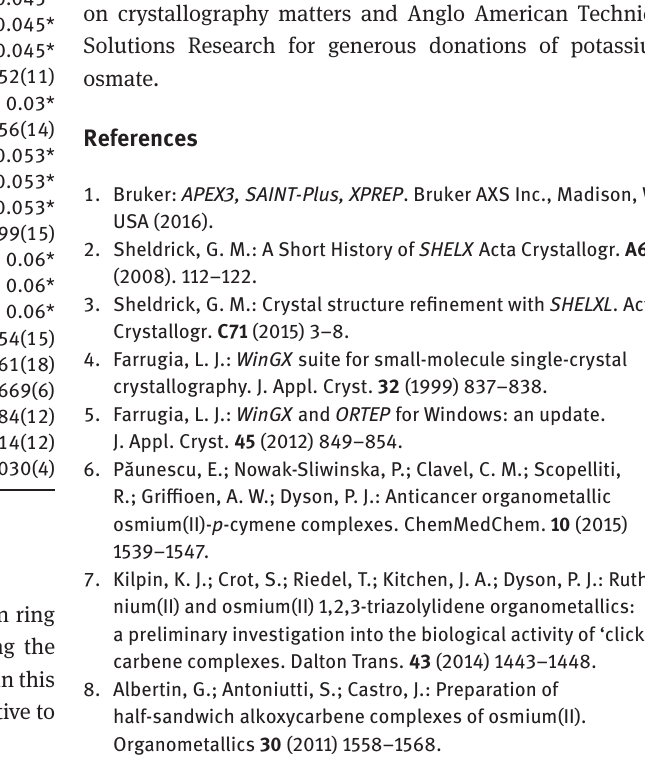
metal atom are ca . 90°, while the bond angles between ring centroid-metal-ligand are ca . 125°. When viewed along the ring centroid-metal centre axis, the unidentate ligands in this structure are oriented in a staggered configuration relative to the arene carbon atoms.